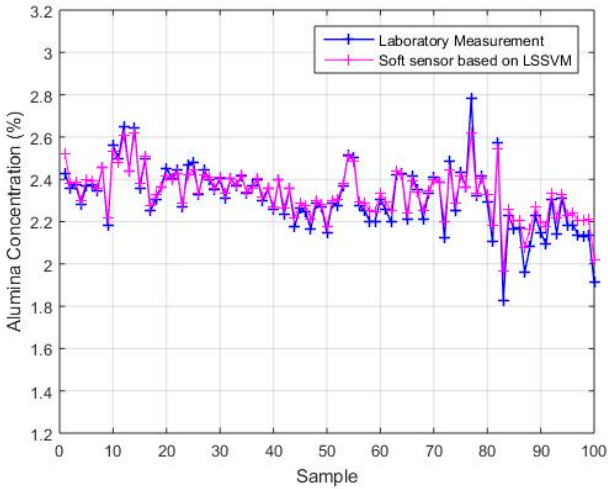
Figure 6. The estimated values of the soft sensor based on a backpropagation (BP) network compared with actual laboratory measurements.